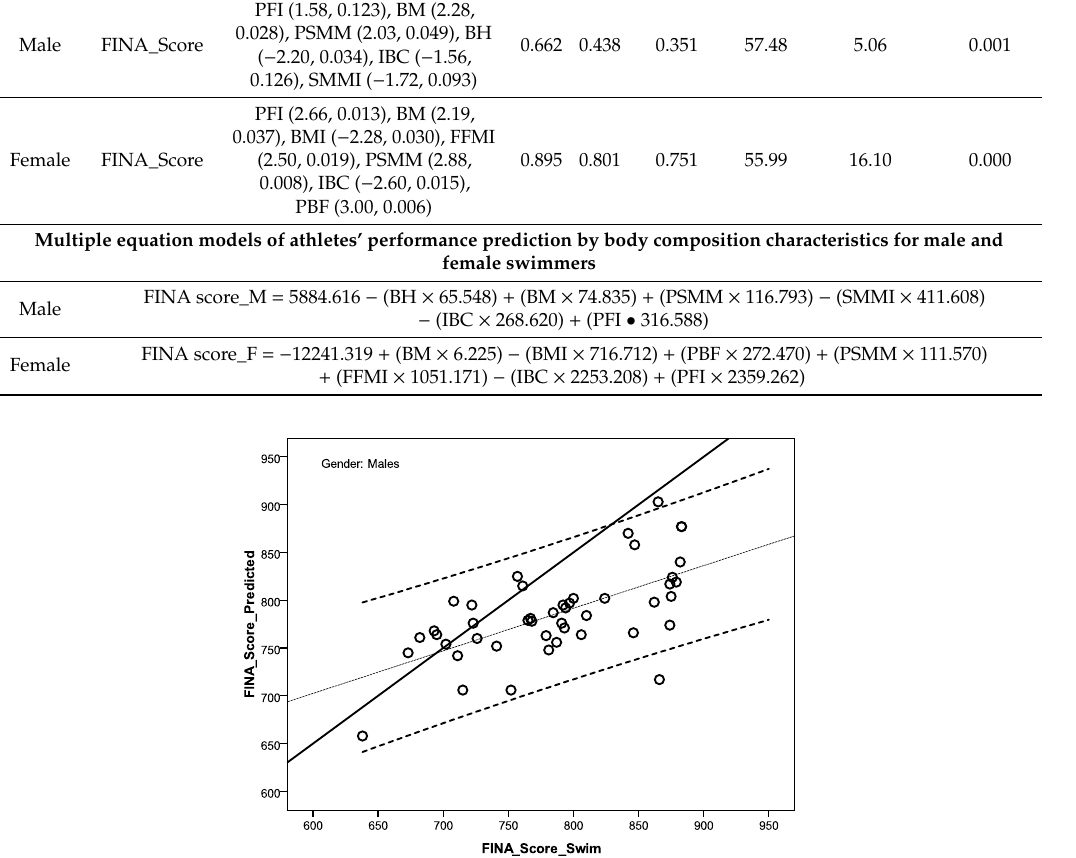
Figure 1. Linear regression for a calculated FINA score and FINA score performance for male sprint swimmers (y = 435.143 × FINA_Score_Swim 0.446 ).